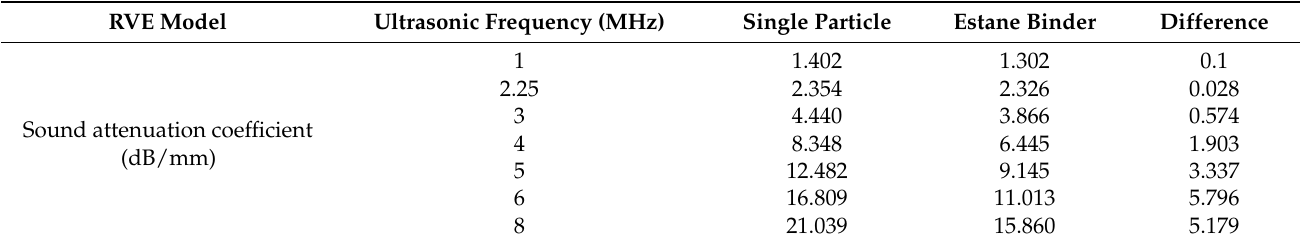
Sound attenuation coefficient (dB/mm)